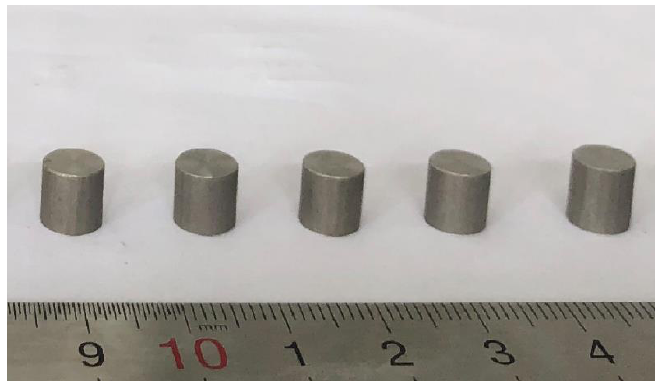
Figure 1. Samples of experiments.